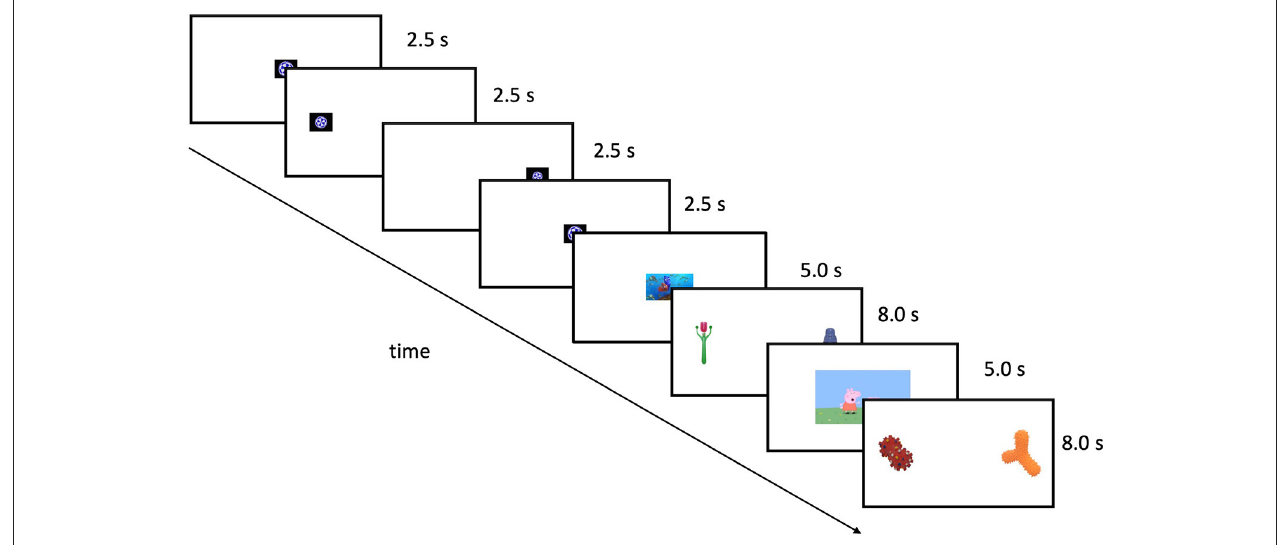
FIGURE 2 | A schematic illustration of the sequence and timing of events during the experiment. Objects came from Horst and Hout